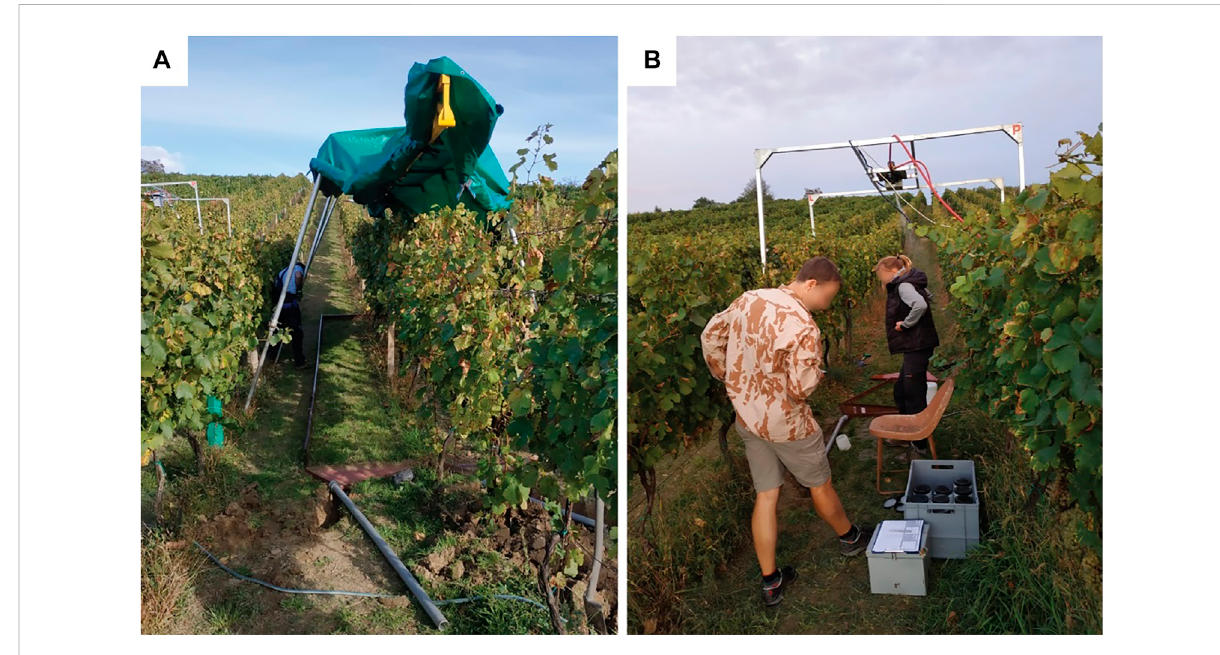
FIGURE 2 The small and large rainfall simulators used for this research. (A) the large rainfall simulator; (B) the small rainfall